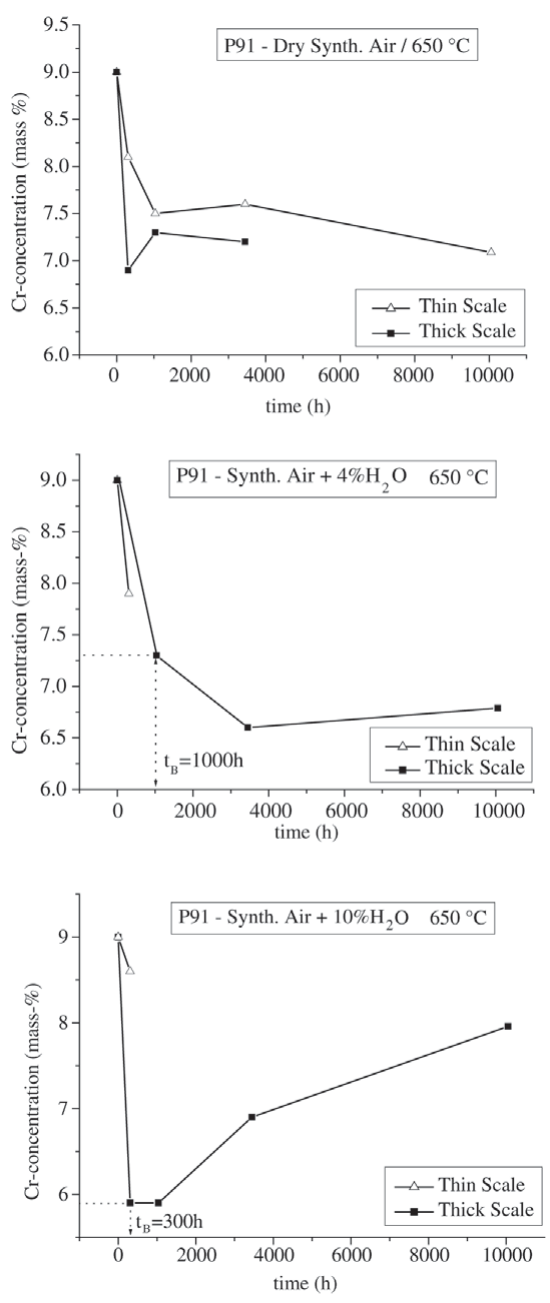
Figure 13. Cr-concentration directly underneath the oxide scale as a function of oxidation time for P91 at 650 °C in 3 different environ- ments (results of EPMA-measurements).